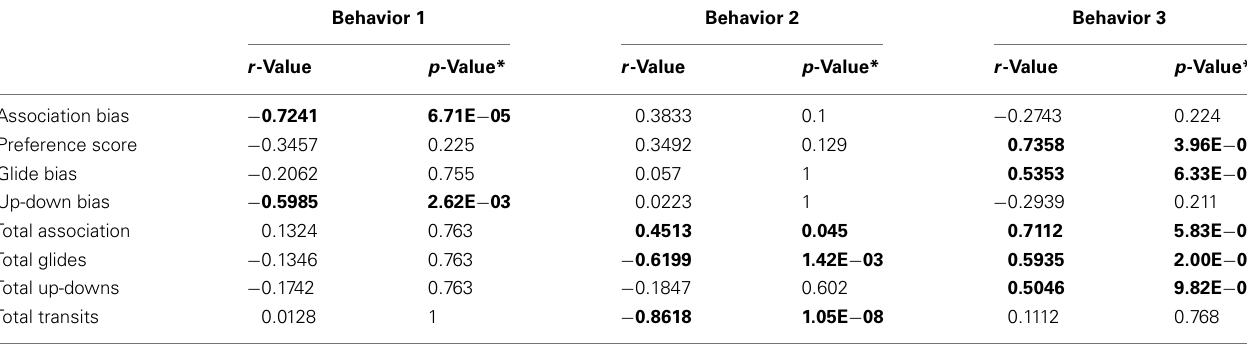
Table 1 | Input behavior loadings onto multivariate